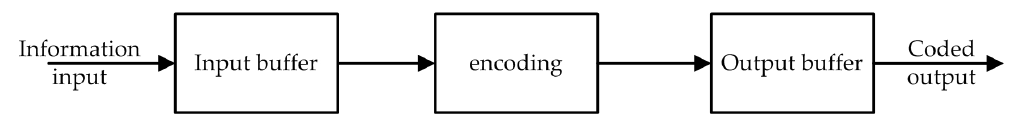
Figure 5. The coding block diagram.